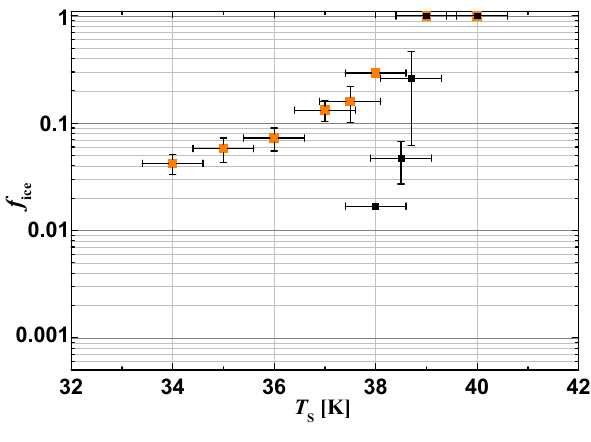
Fig. 7. FLUENT/FPM model simulations for LACIS adjustments to measure possible deposition nucleation. The maximum saturation ratios with respect to ice (blue) and liquid water (green) are plotted versus T s for two different inlet dew-points (265.95K (triangle) and 260.95K (square)). The black boxes represent the measurement